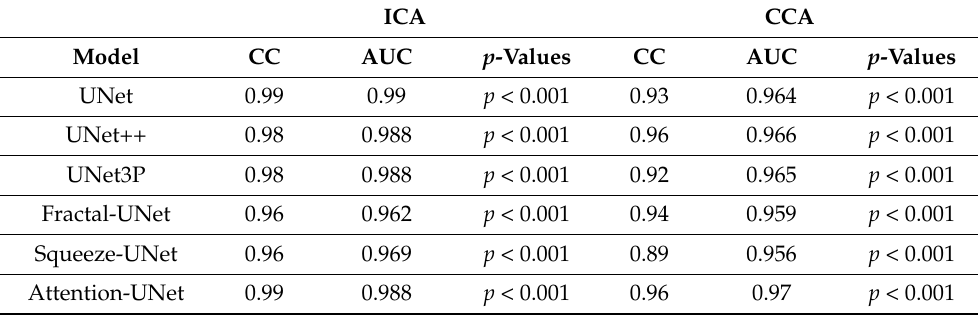
Table 5. Performance parameters of all UNet models for ICA and CCA database experiments. ICA